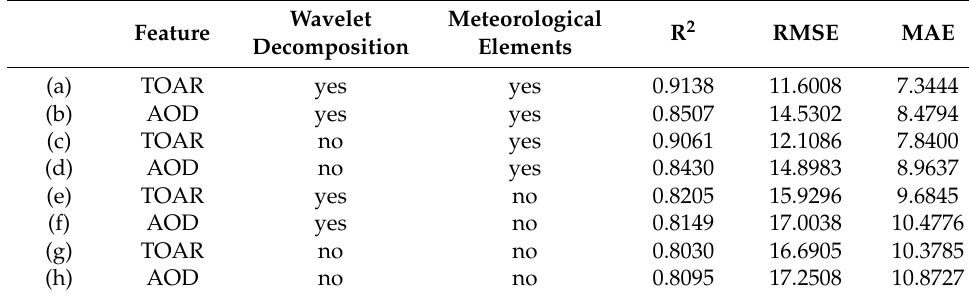
Table 4. Model design and